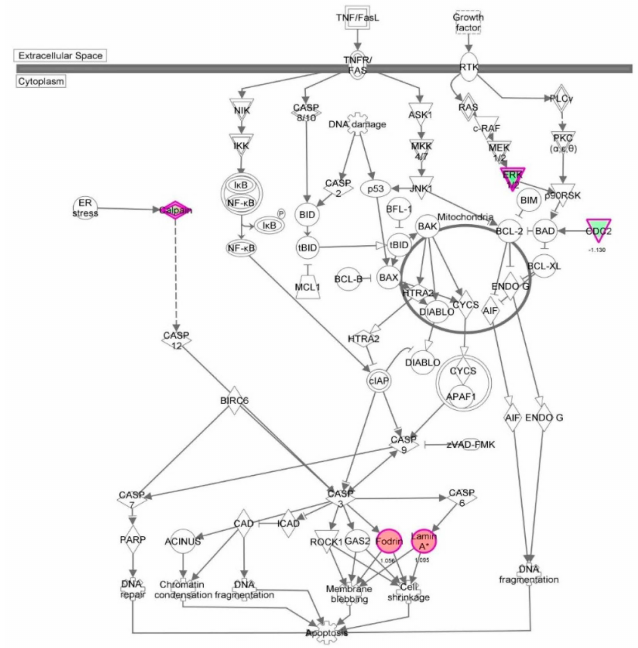
Figure 28. Apoptosis signaling pathway was regulated by vancomycin in HK-2 cells. HK-2 cells were treated with 50 µ g/mL vancomycin for 24 h and the protein samples were subject to quantitative proteomic analysis. Red indicates an up-regulation; green indicates a down-regulation. The intensity of green and redcolors indicates the degree of down- or up-regulation. Solid arrow indicates direct interaction and dashed arrow indicates indirect interaction.